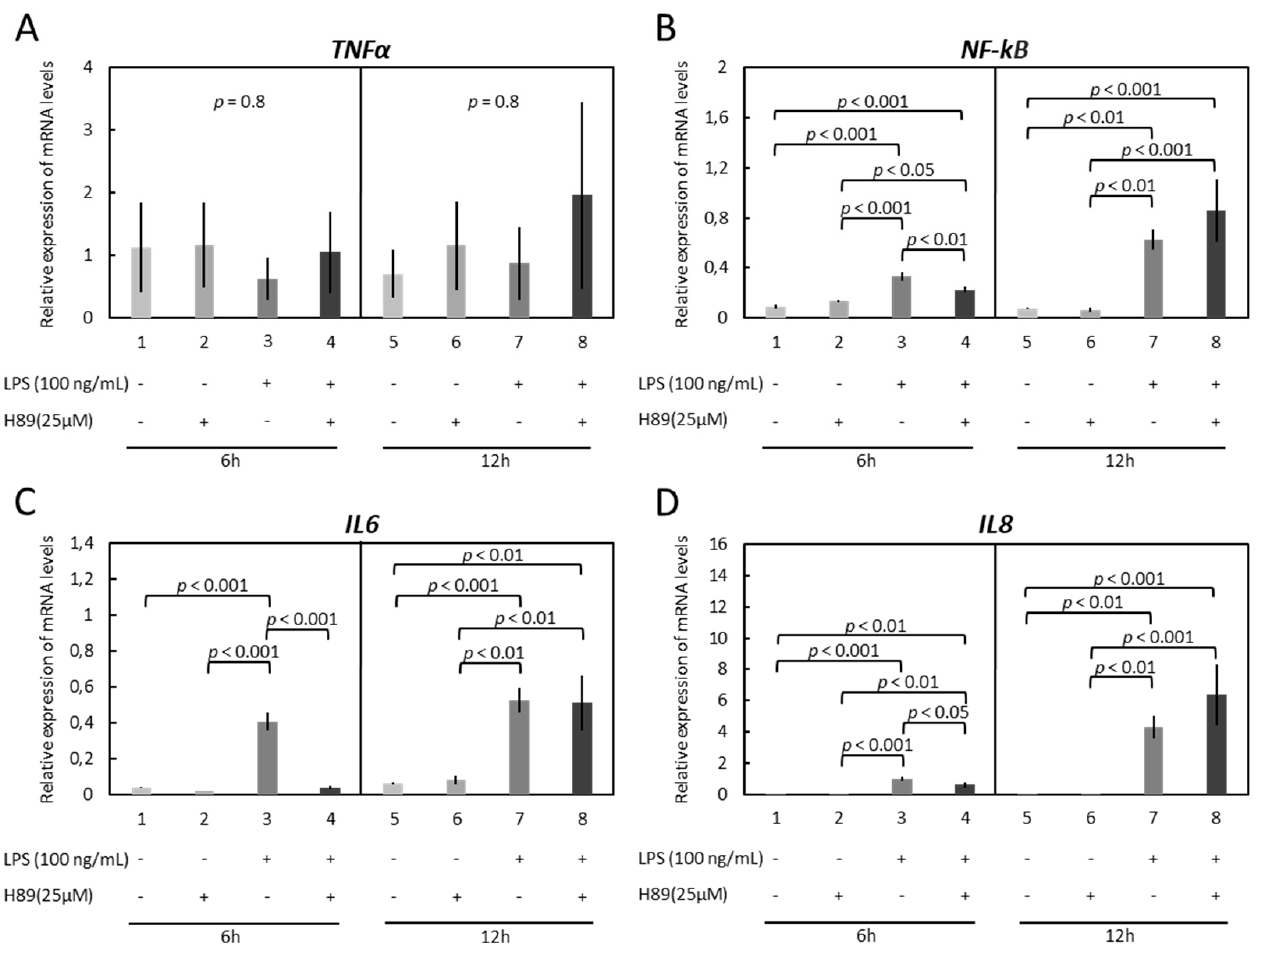
Figure 4. Effects of LPS treatment and inhibition of PKA (H89) activity on expression of TNF α , NF-kB , IL6 and IL8 in immortalized OLENDO cells. Expression of TNF α ( A ), NF-kB ( B ), IL6 ( C ), and IL8 ( D ) as determined by real-time (TaqMan) PCR. Inhibition of PKA (H89) activity was performed as described in the Materials and Methods. A parametric one-way ANOVA was applied followed by the Tukey–Kramer multiple comparisons post-test. All numerical data are presented as the means ± S.D. p -values < 0.05 were considered significant and are indicated.